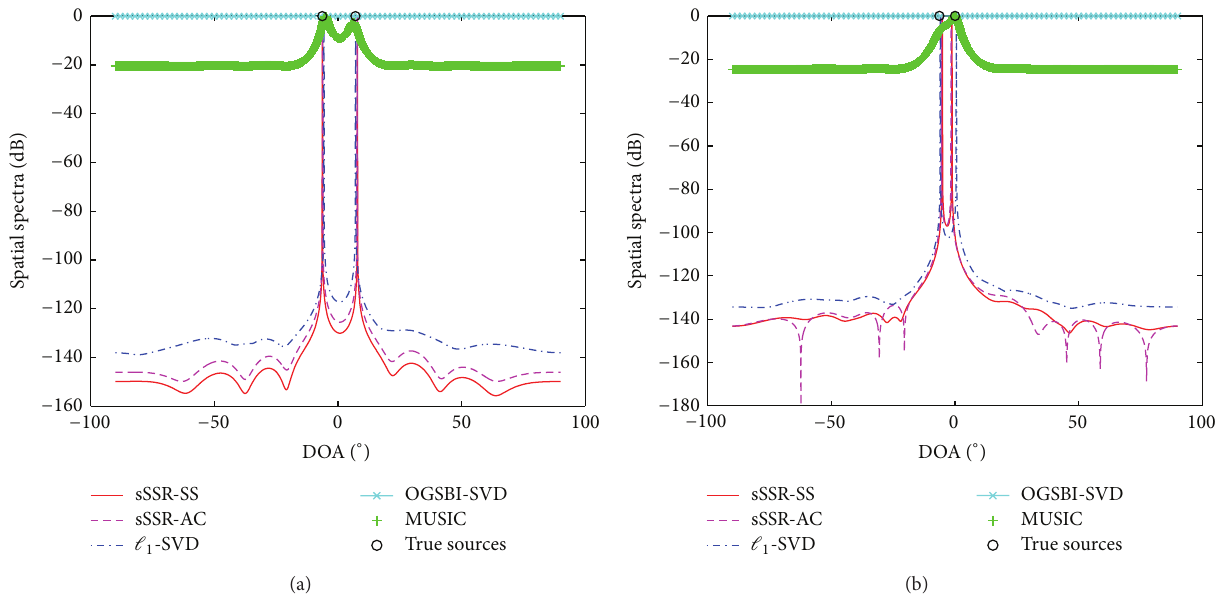
Figure 1: Spatial spectra of ℓ 1 -SVD, OGSBI-SVD, MUSIC, sSSR-AC, and sSSR-SS in real data tests for (a) sources from [−6.25 ∘ , 7.05 ∘ ] and (b) sources from [−6.25 ∘ ,0 ∘ ] .